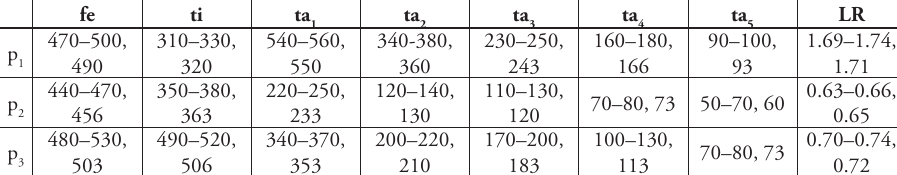
Table 3. Lengths (µm) and proportions of adult male legs in Parachironomus poyangensis sp. n. (n=3).